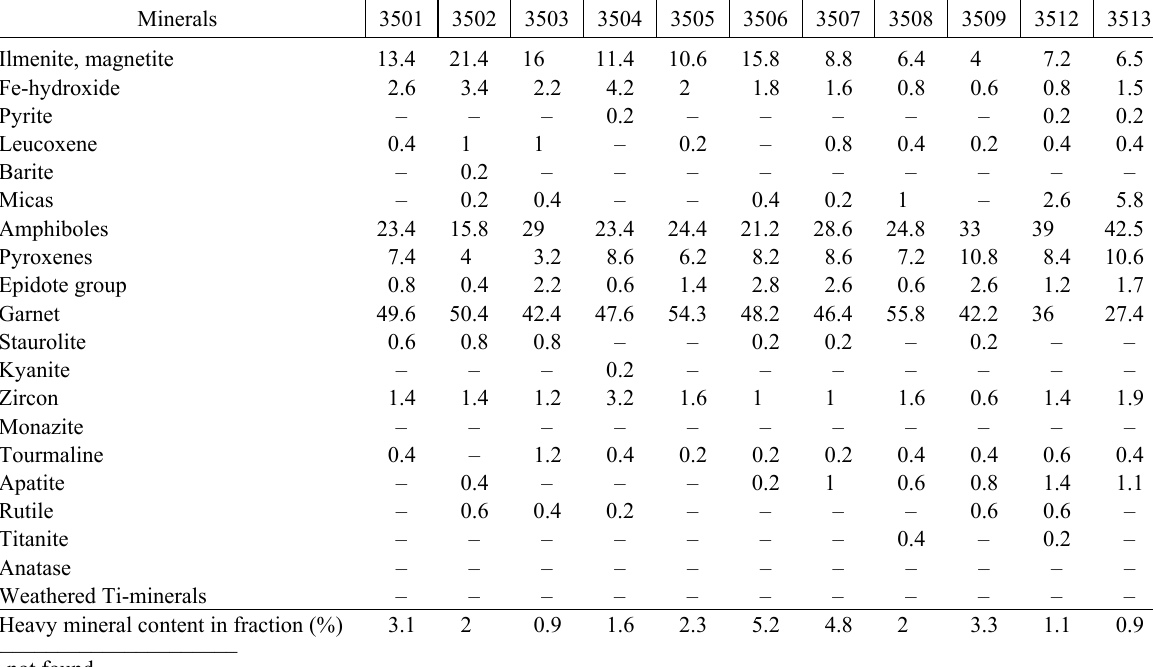
Table 4. Results of optical microscopy analysis of Lemme samples 3501–3509, 3512 and 3513 (grain counts (%), 0.1–0.25